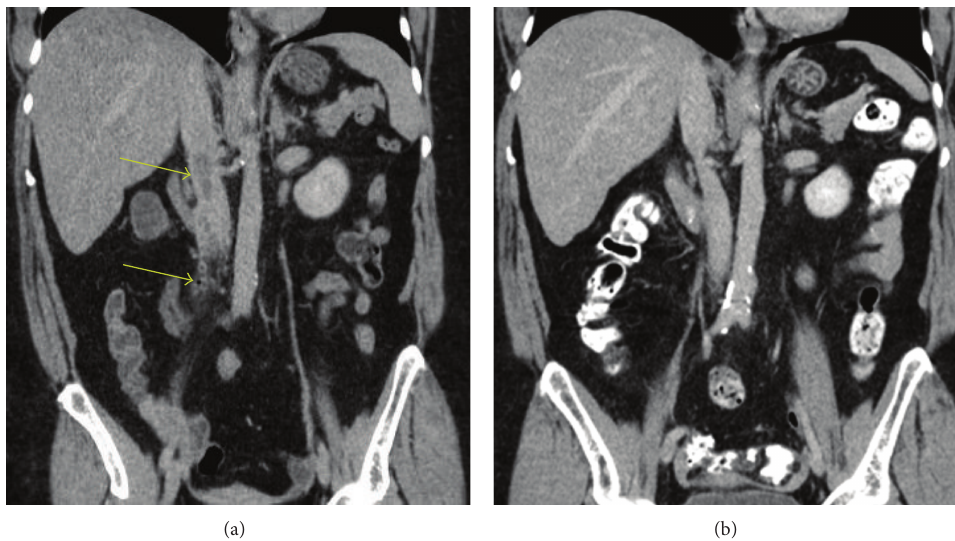
Figure 1: (a) Septic deep vein thrombosis of the right ovarian vein with extension into the inferior vena cava. Dilation of the right ovarian vein, with a filling defect and air bubble, is seen in the proximal right ovarian vein, surrounded by fat stranding (lower arrow). This filling defect extends into the IVC at the level of the renal veins (upper arrow). These findings are consistent with septic deep thrombophlebitis of the proximal right ovarian vein with extension into the IVC. (b) 2.5 months later, there has been a complete resolution of septic thrombophlebitis of the right ovarian